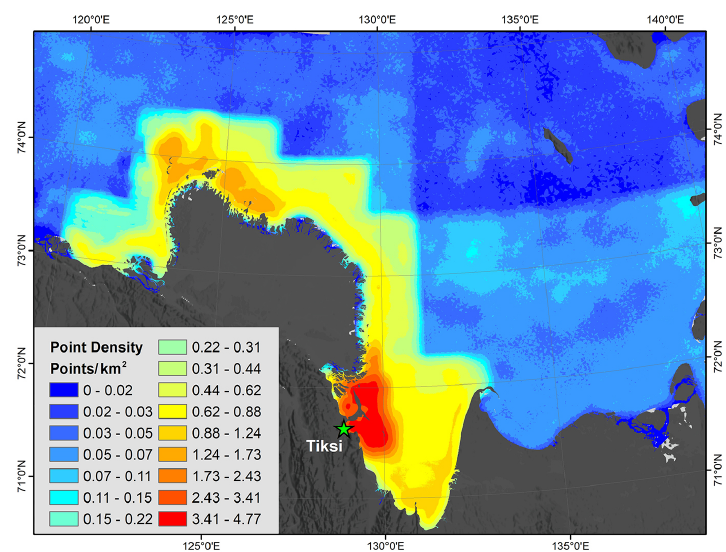
Figure D1. Point density for the Lena Delta bathymetrical models (TTR 50 + TTR 200 ), indicating the highest point density in the coastal areas around Bykovsky Peninsula. The green star shows the location of the city and harbor of Tiksi.